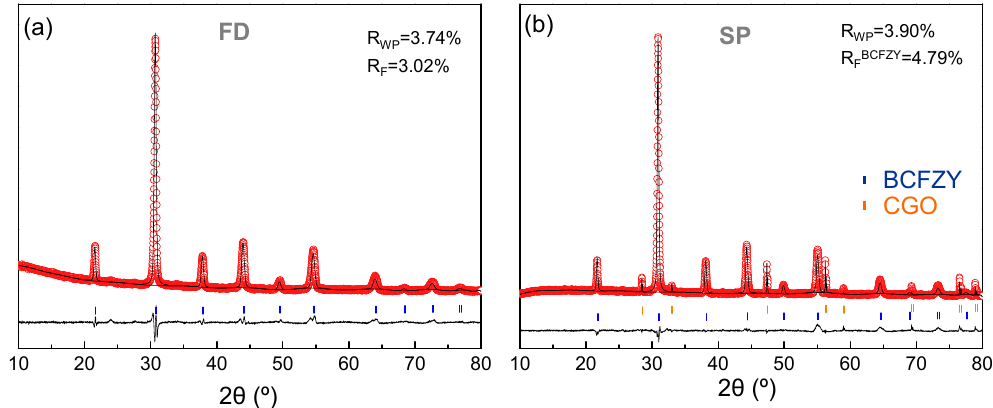
Figure 1. X-ray powder diffraction (XRD) Rietveld fitting of BaCo 0.4 Fe 0.4 Zr 0.1 Y 0.1 O 3- δ (BCFZY) cathodes